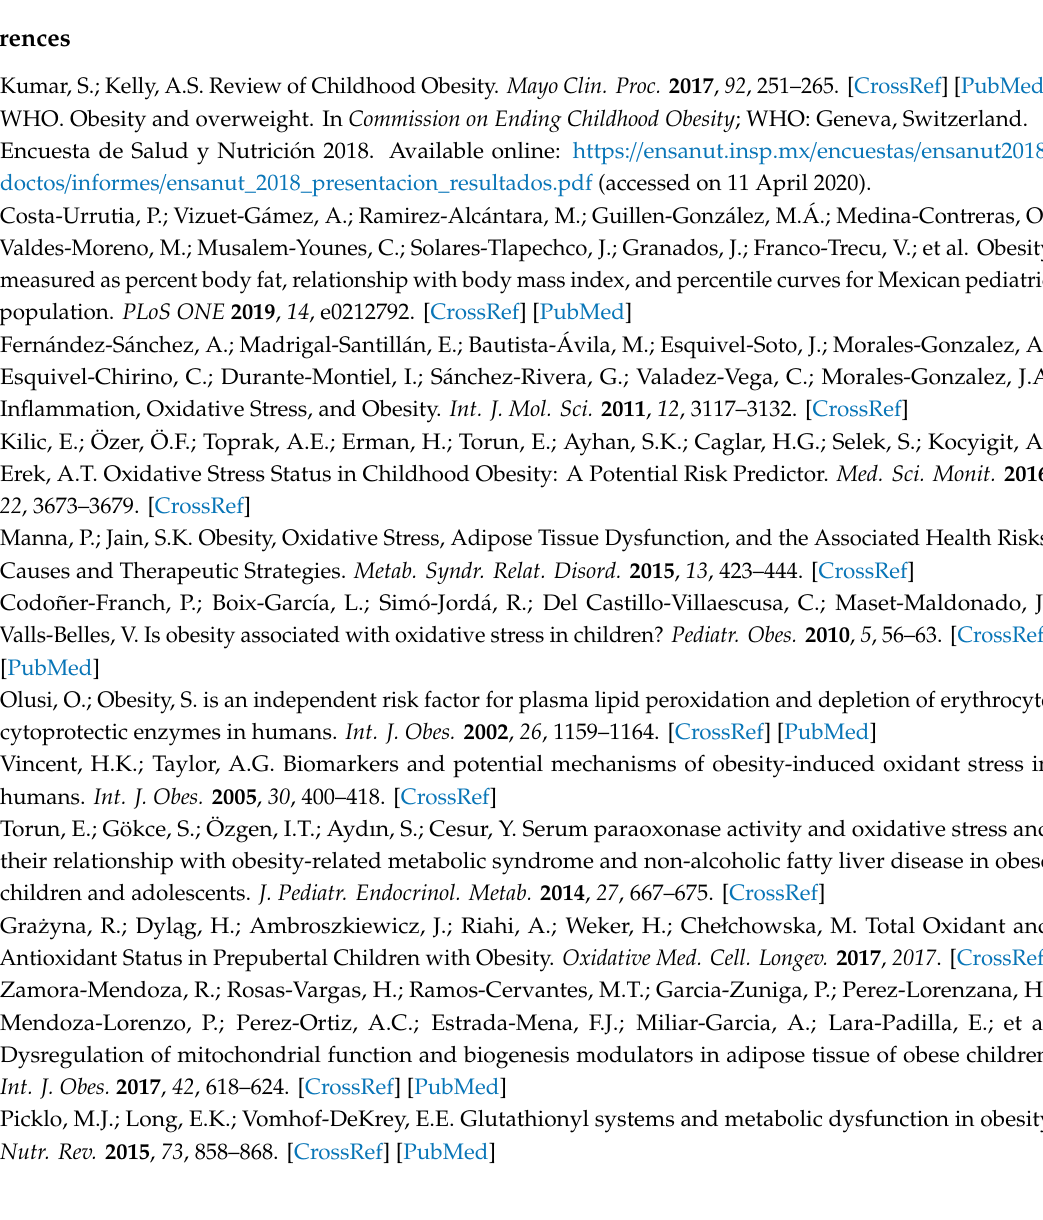
Figure S1: Linkage disequilibrium and association plot of GPX3, GPX4, GPX5, GPX6, GPX7, PON1, PON2, and PON3 in Mexican children. A) Block 1 in GPX4, block 2 in GPX5 and GPX6, and block 3 in GPX7. B) Blocks 4 to 7 in PON1, block 8 in PON3, and blocks 9 and 10 in PON2. C) Blocks 11 to 13 in in GPX3, Table S1: Selected SNPs in GPX and PON genes; chromosome (Chr), minor allele (Allele), minor allele frequency (MAF),